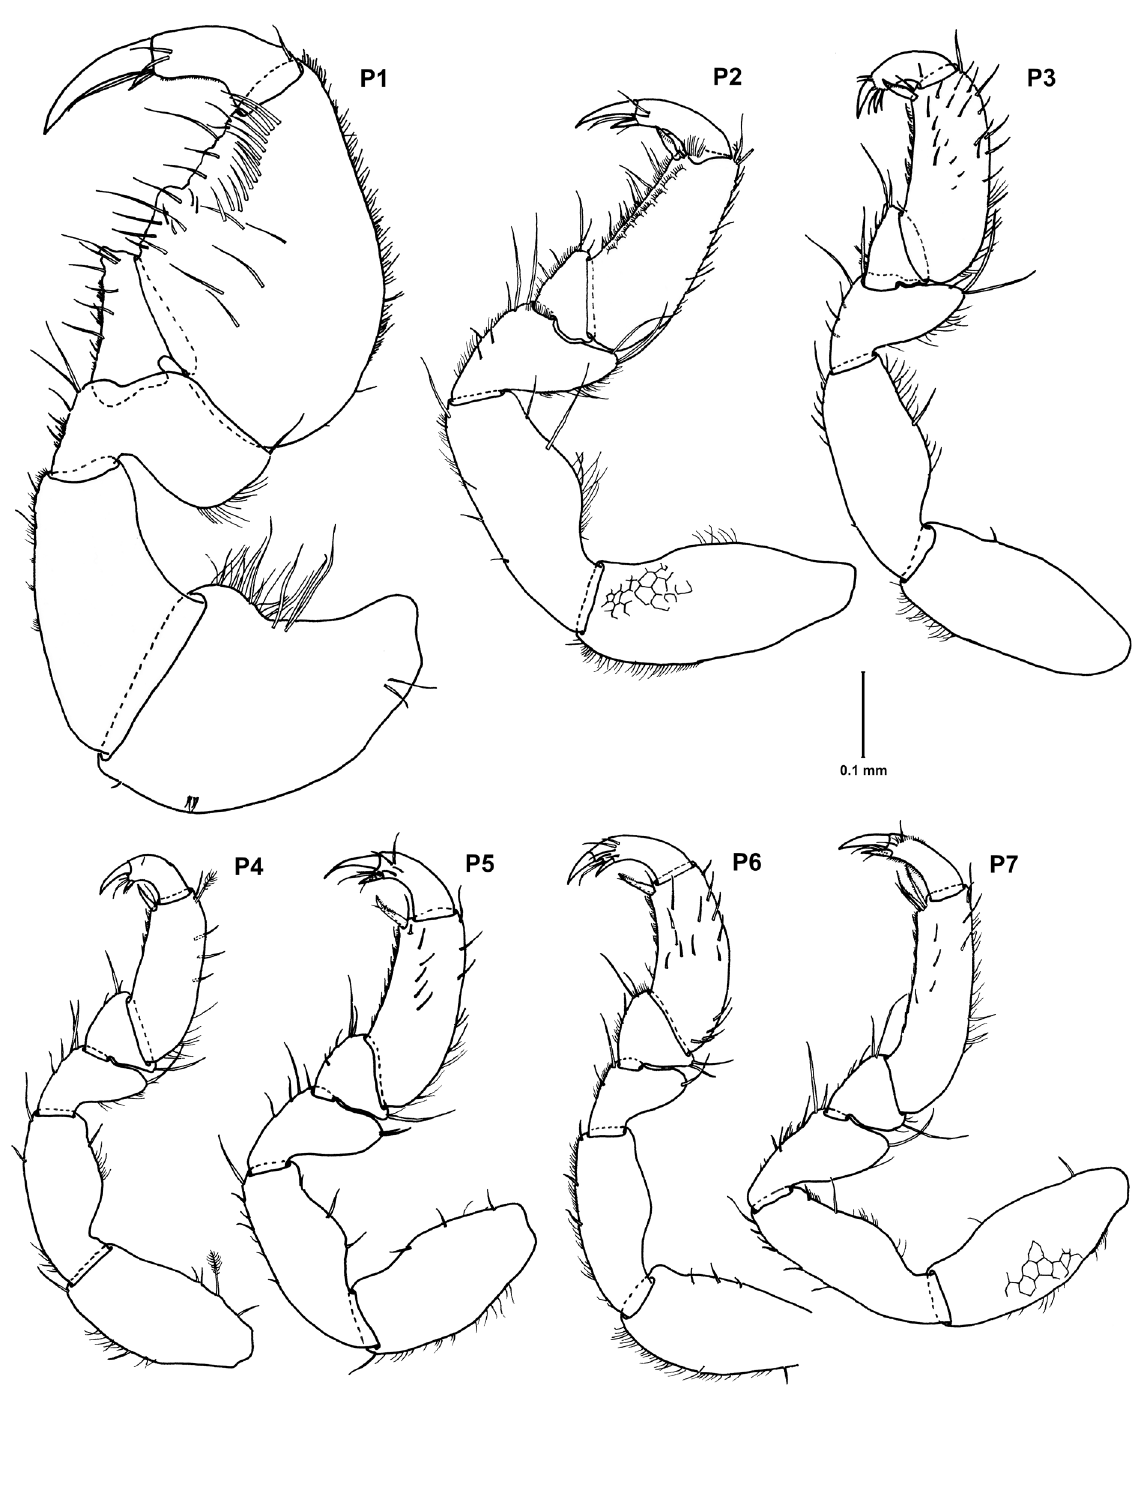
Fig. 15. Pendanthura bangkaensis sp. nov., ♀, holotype (MZB Iso 104). Abbreviations: P1–P7 = pereopods